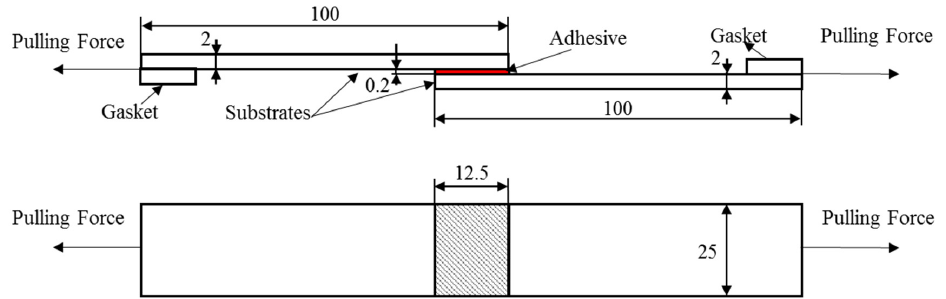
Figure 3. Form and dimensions of the single lap joint (units: mm).